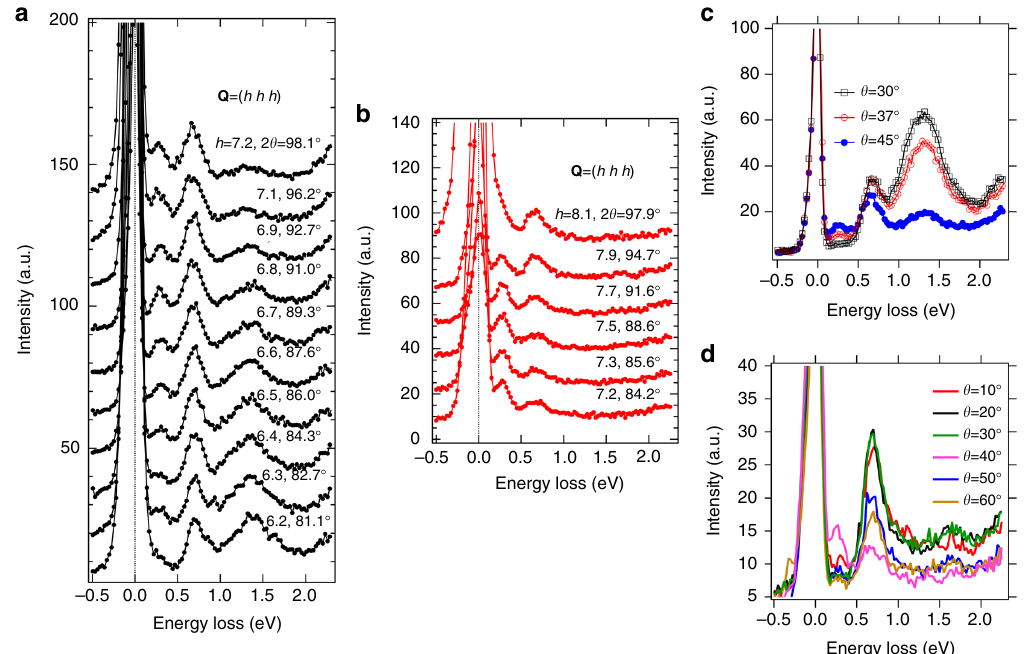
Fig. 3 L 3 - and L 2 -edge RIXS spectra. a , b L 3 -edge ( E i = 9.879 keV) a and L 2 -edge ( E i = 11.133 keV) b RIXS spectra as a function of momentum transfer Q and energy loss. Three orbital excitations are clearly noticed at the 0.27, 0.7, 1.3 eV energy-loss positions in a . In sharp contrast, only two peaks at 0.27 and 0.7 eV are visible in b , and the broad peak at 1.3 eV is not observed. c , d L 3 -edge c and L 2 -edge d RIXS spectra as a function of incident sample angle θ and energy loss. 2 θ is fi xed at 90°. Clearly, the broad peak at 1.3 eV is absent for L 2